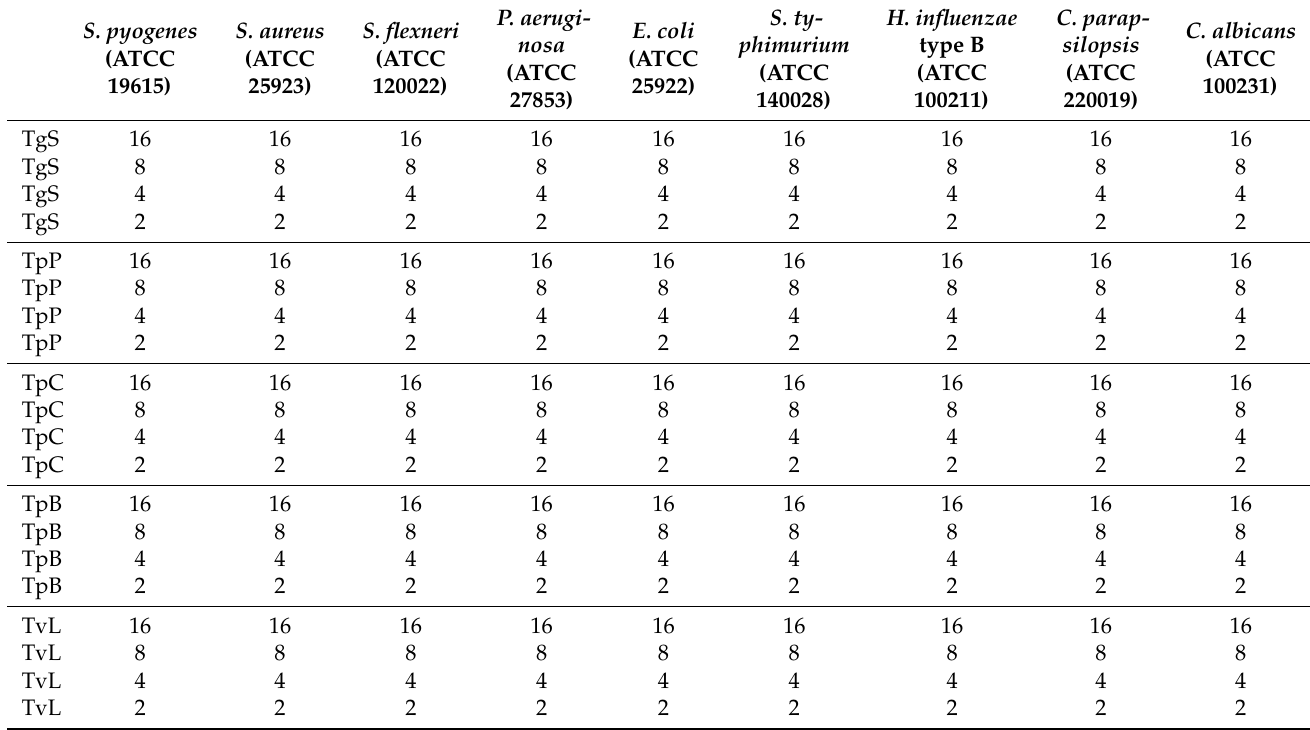
Table 4. MIC ( µ L EO/100 µ L) for TgS, TpP, TpC, TpB and